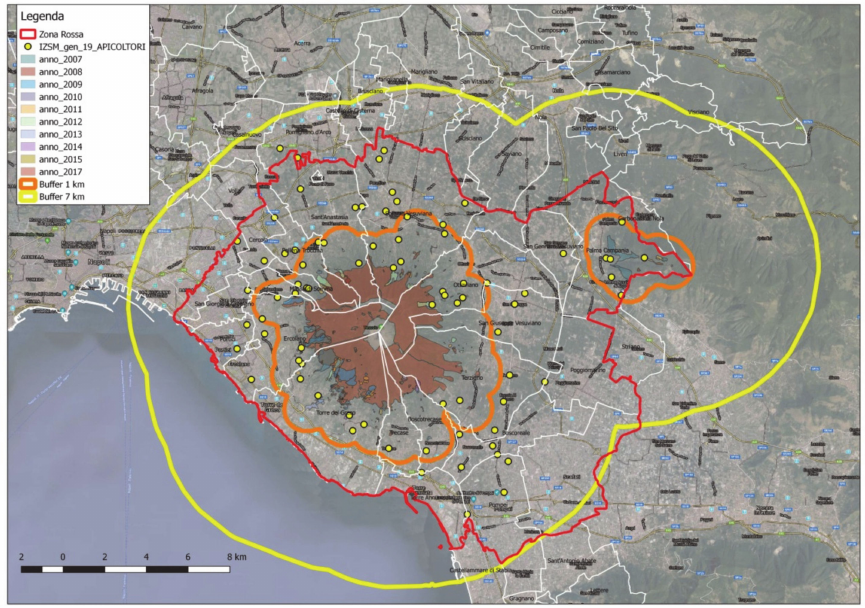
Figure 8. Bu ff er zones interested by direct (inner zone) and indirect (outer zone) e ff ects of fires on beekeepers’ farms for the period